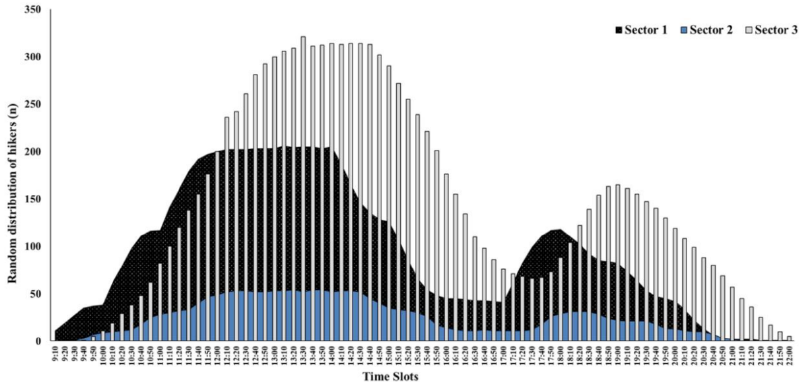
Figure 9. Monte Carlo simulation according to sector for the trail